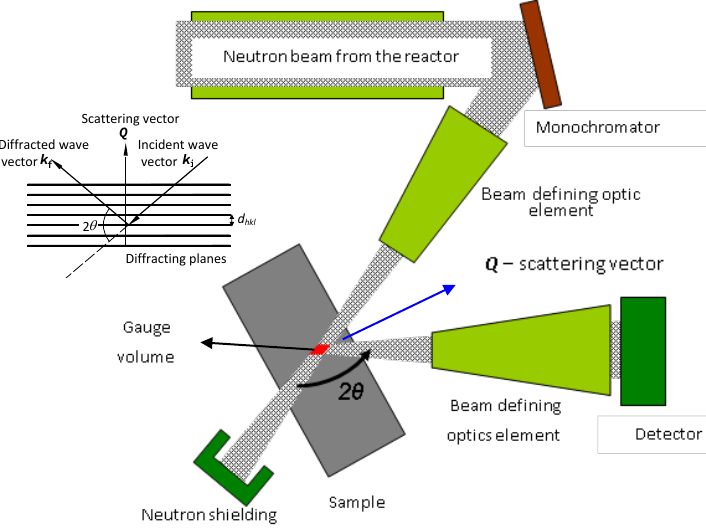
Figure 1. Scheme of the conventional strain scanner.